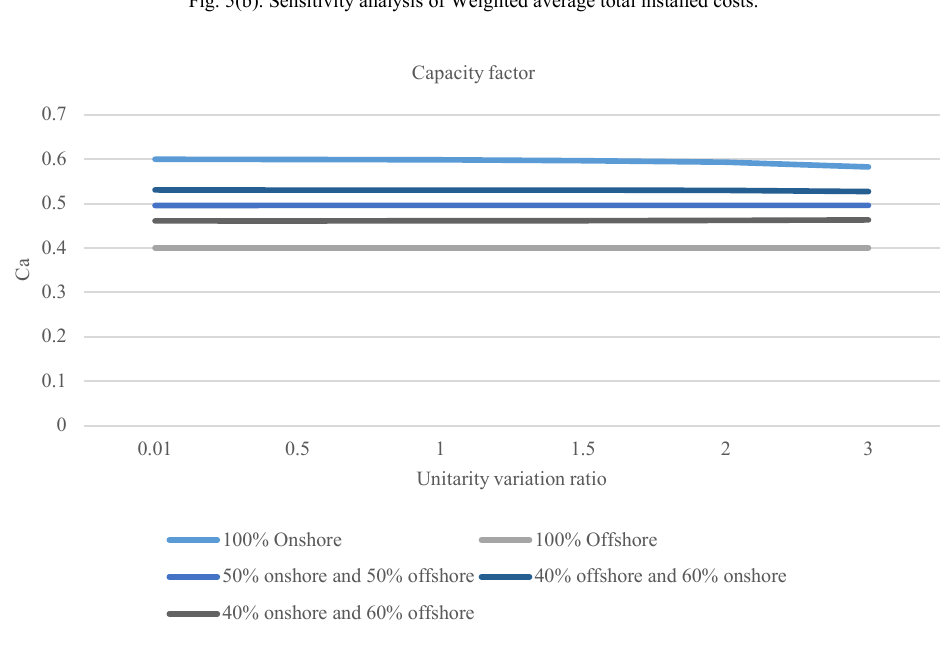
Fig. 5(c). Sensitivity analysis of Capacity